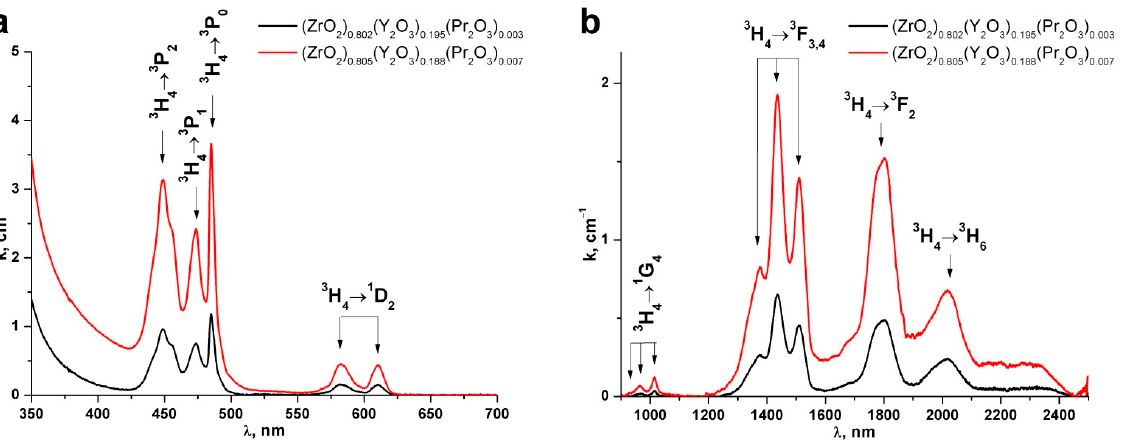
Figure 4. Absorption spectra of Pr 3+ /Pr 4+ ions in (ZrO 2 ) 0.805 (Y 2 O 3 ) 0.188 (Pr 2 O 3 ) 0.007 and (ZrO 2 ) 0.802 (Y 2 O 3 ) 0.195 (Pr 2 O 3 ) 0.003 crystals recorded in ( a ) 350–700 and ( b ) 900–2500 nm ranges.